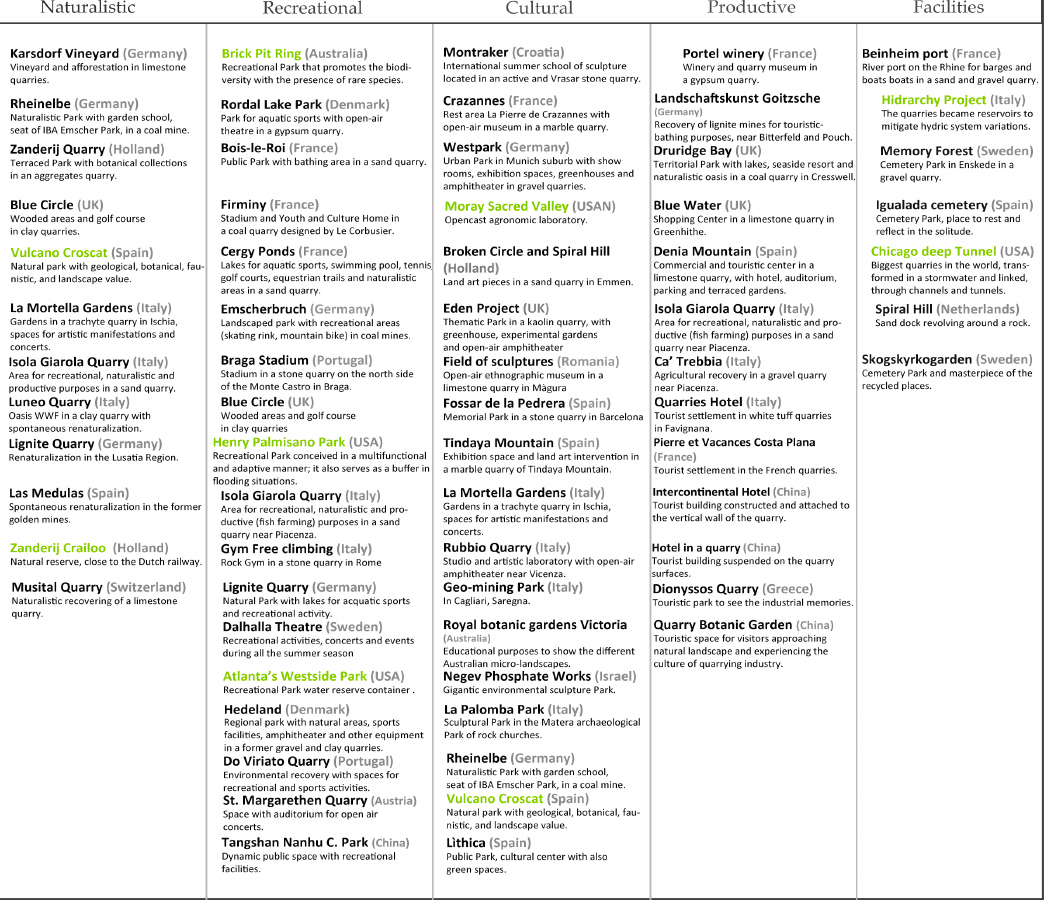
Figure 7. Some of the selected quarry rehabilitation projects (the projects with sustainable and environmental components are illustrated in green).